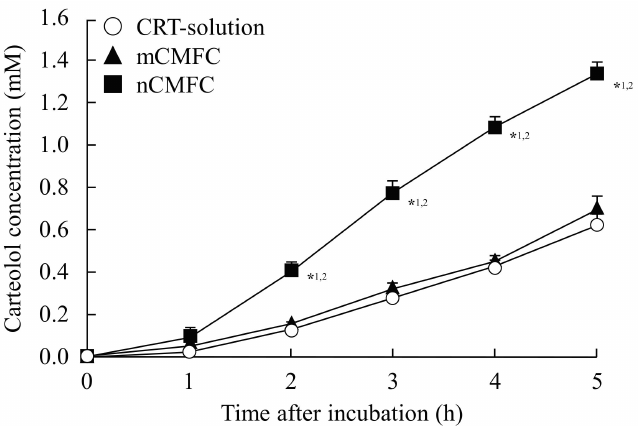
Figure 3. In vitro transcorneal penetration of carteolol from nCMFC. CRT-solution ( solution-treated cornea. mCMFC ( (cid:78) ), mCMFC-treated cornea. nCMFC ( (cid:4) ), nCMFC-treated cornea. n = 7. * 1 p < 0.05, vs. CRT-solutions for each category. * 2 p < 0.05, vs. mCMFC for each category.